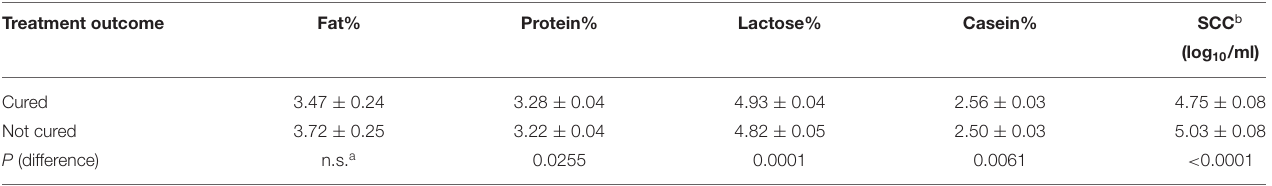
TABLE 7 | Estimated means ( ± std. err.) of milk components and SCC based on treatment outcome resulting from ANOVA analysis for repeated measurements (see Table 6